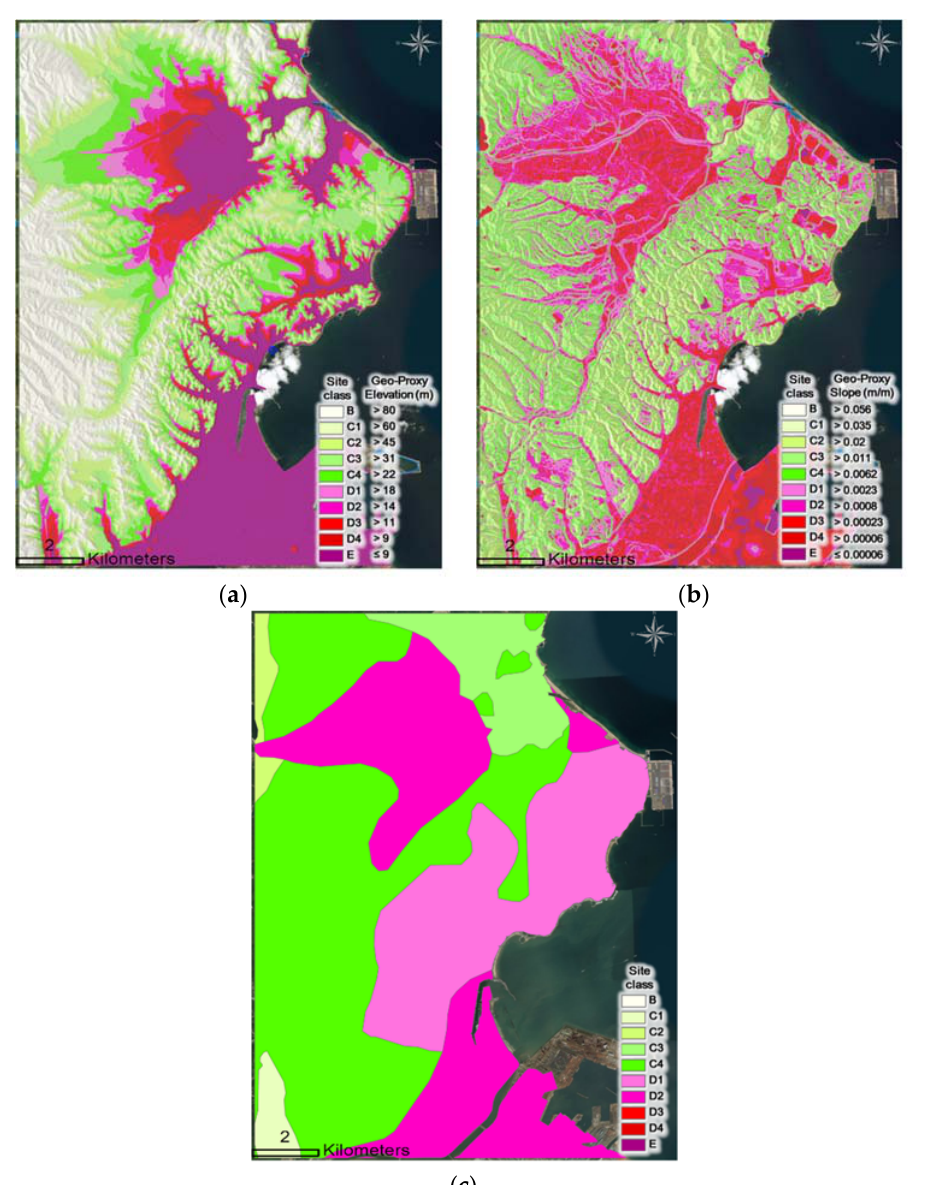
Figure 7. Seismic zonation for geo-proxy-based, site-specific effects: ( a ) elevation; ( b ) slope; ( c ) geology (geological description).